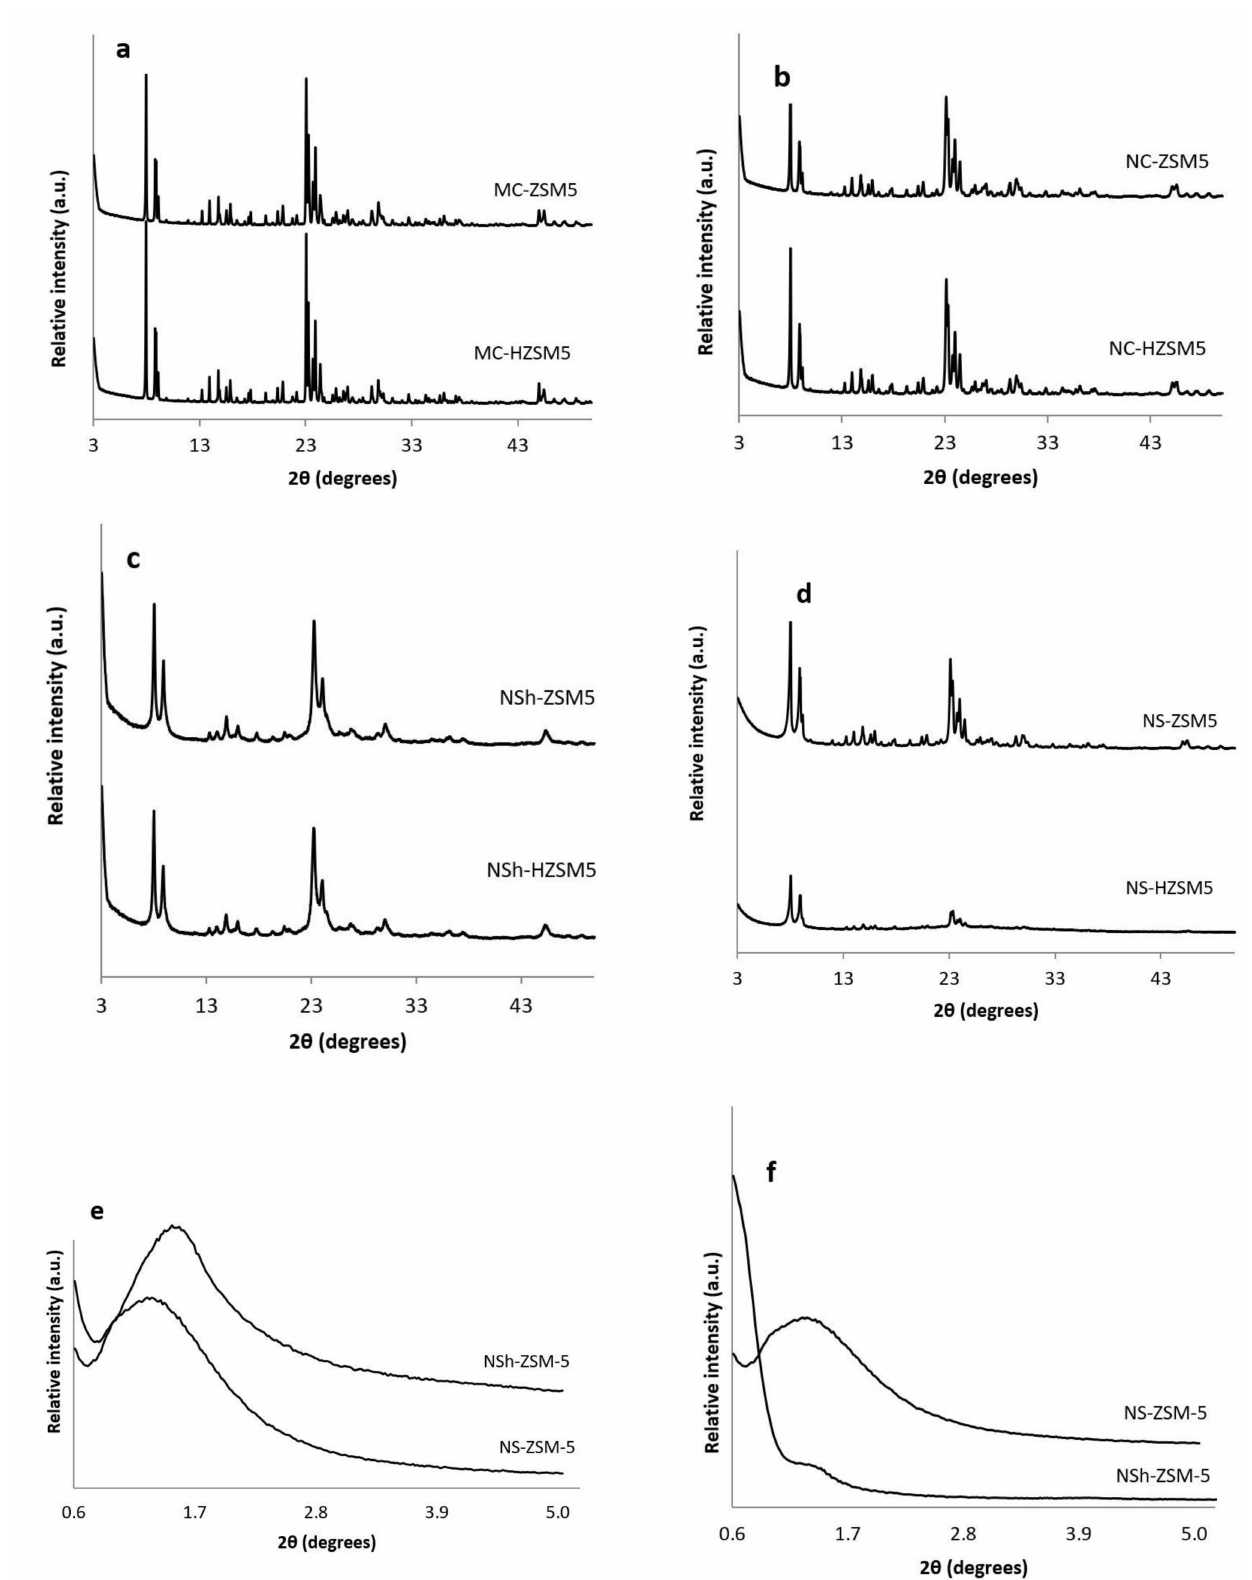
Figure 1. XRD diffractograms of ( a ) calcined MC-ZSM5 and MC-HZSM5 at wide angles, ( b ) calcined NC-ZSM5 and NC-HZSM5 at wide angle patterns, ( c ) calcined NSh-ZSM5 and NSh-HZSM5 at wide-angles, ( d ) calcined NS-ZSM5 and NS-HZSM5 at wide-angles, ( e ) non-calcined NSh-ZSM5 and NS-ZSM5 at low-angles, ( f ) calcined NSh-ZSM5 and NS-ZSM5 at